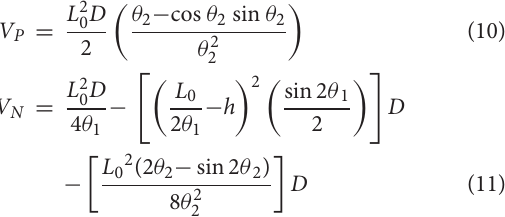
This equation can be solved numerically or by using an approximation such as the Taylor series expansion. The area A p of the positive pressure sub-actuator can be approximated as an airfoil shape with cylindrical surfaces as done in previous works on pouch